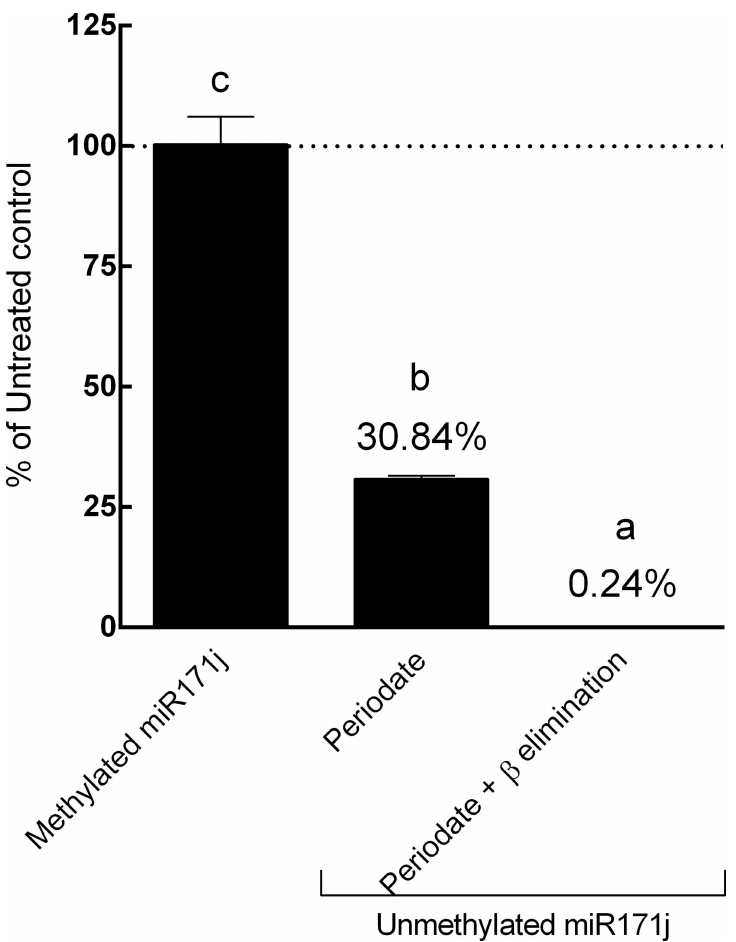
Fig 6. Comparison of periodateoxidation and β elimination methods in thelivermatrix. 20ngof methylated miR171jor20ngofunmethylatedmiR171jwereaddedto 2000ngof mouselivertotalRNAtreatedwithperiodate alone,orfollowedby β elimination,andanalyzedbyqRT-PCRasdescribedinMaterialsandMethods.Datais presented as a percentageof miR171jdetectedinthe treatment groupto thatof thecontrolgroup.Columns markedwithdifferentlettersaresignificantlydifferentfromeachother( p (cid:20) 0.05,datapresentedas Mean ± SD).